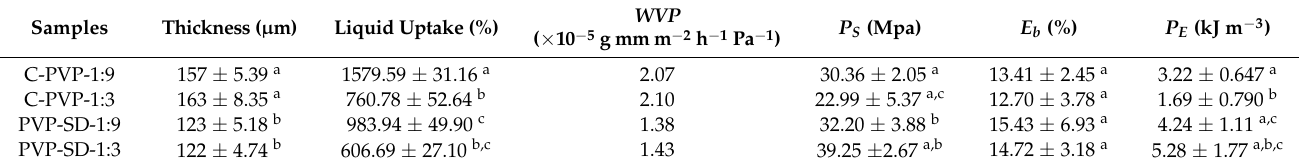
Table 3. Thickness, liquid uptake ability at equilibrium (120 min), water vapor permeability (WVP), and mechanical properties of PVP films. Tests were performed in triplicate (mean ±